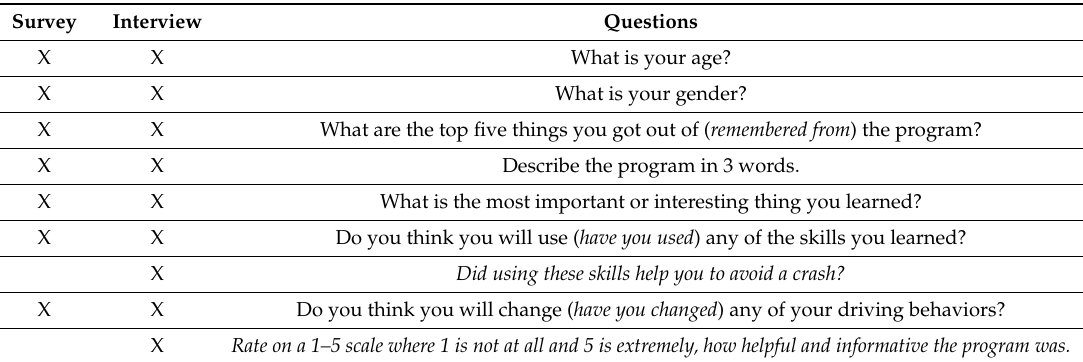
Table 1. Survey and follow-up phone interview questions. The words in italics were used for the follow-up phone interview.